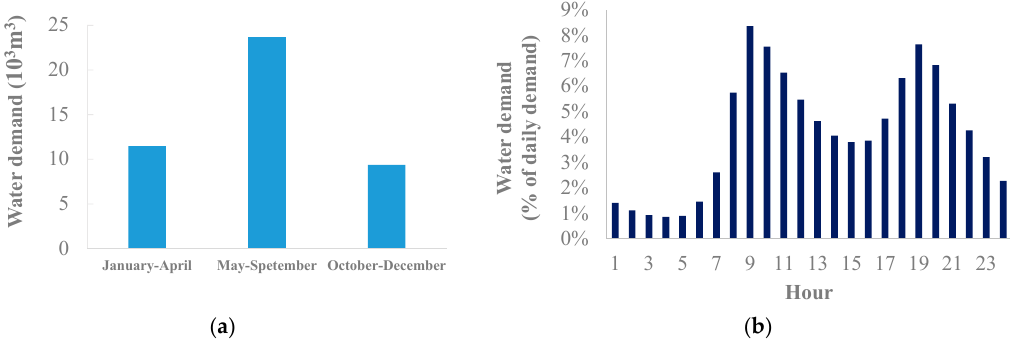
Figure 5. ( a ) Water demand in Merichas for each period of the year and ( b ) distribution of the water demand during the day [21].